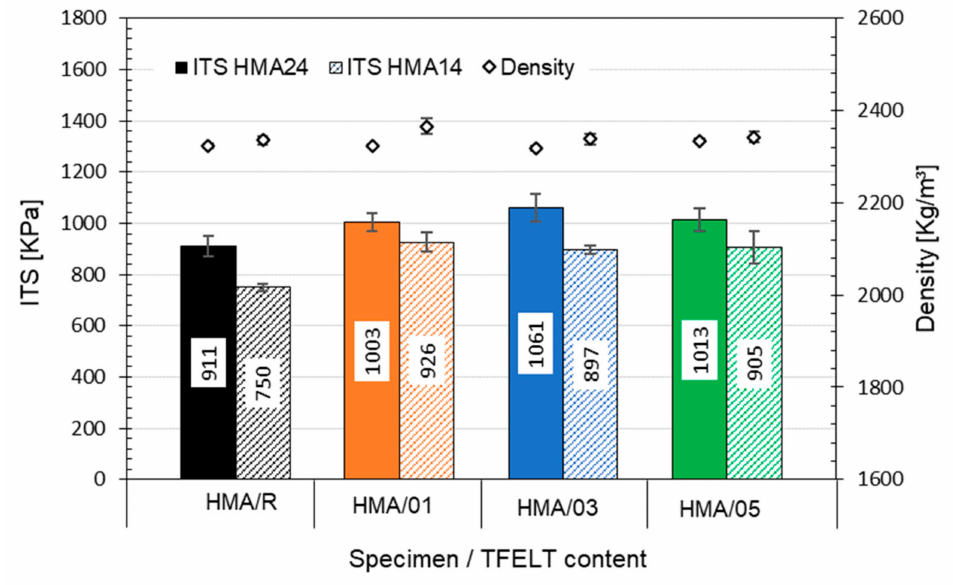
Figure 10. Indirect tensile strength test results at 25 ◦ C for all the mixes